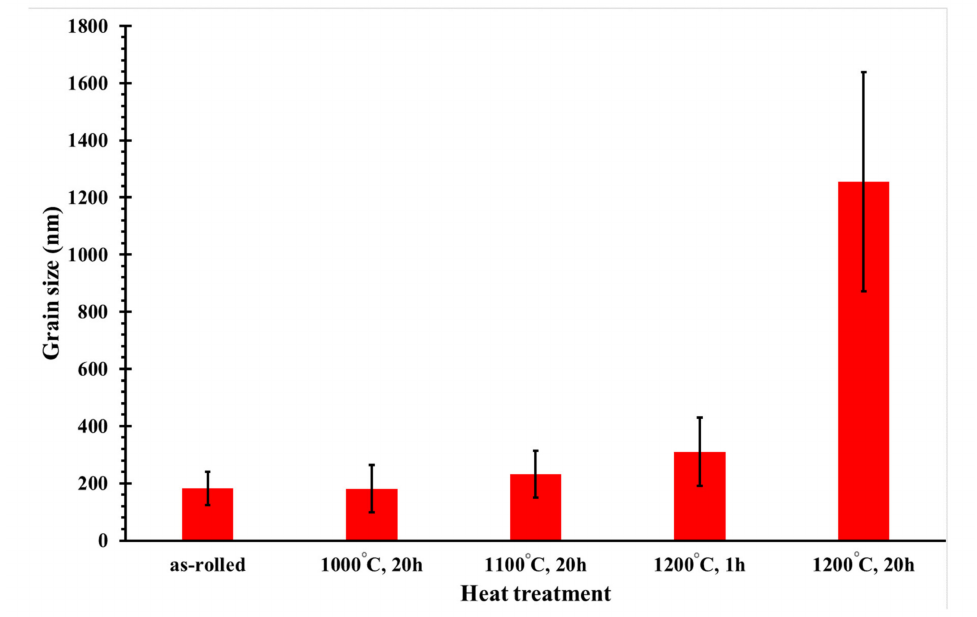
Figure 4. Dependence of mean grain size on the heat treatment